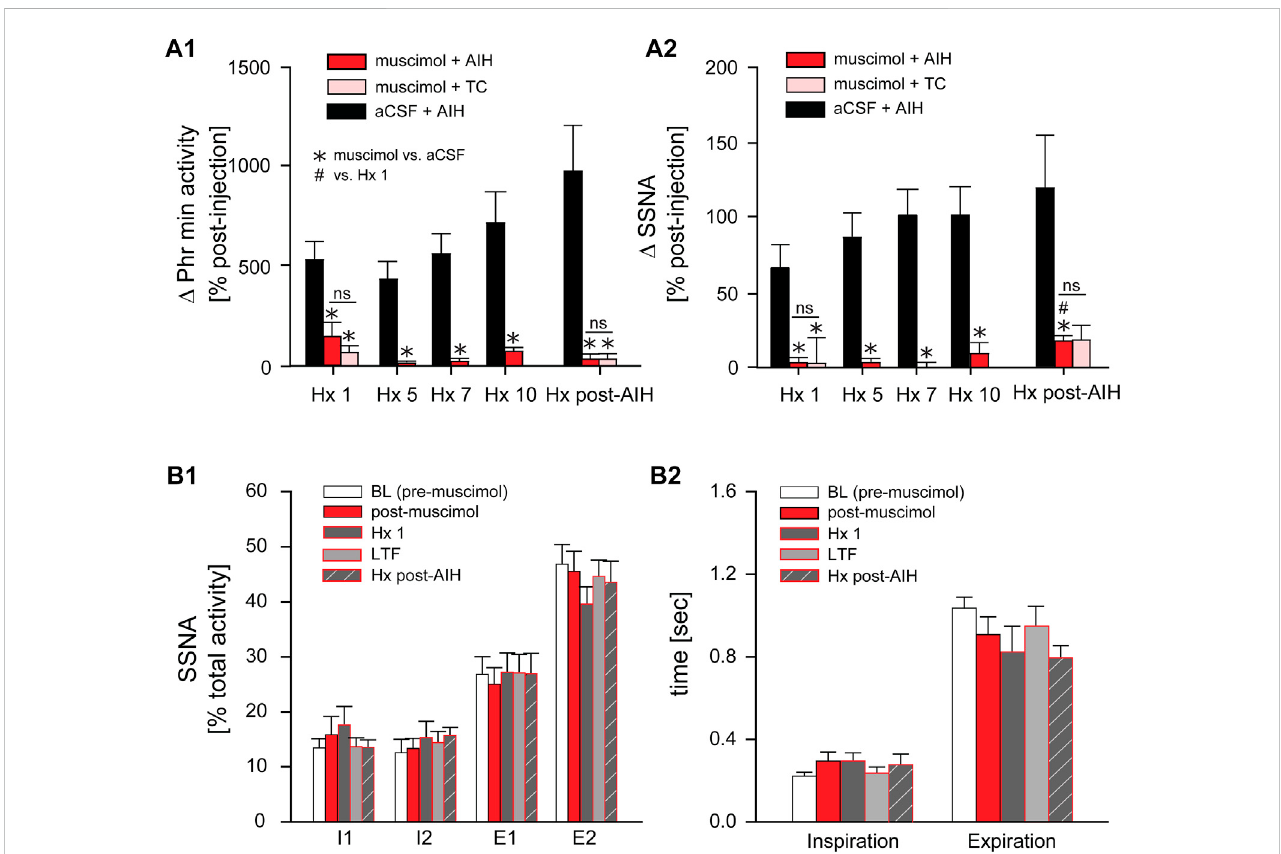
FIGURE 7 Inhibition of nTS activity prior to AIH inhibits PhrNA and SSNA responses to Hx with no changes in sympathorespiratory coupling. (A) : Change in PhrNA (A1) and SSNA (A2) during Hx 1, 5, 7, 10 and Hx post-AIH. Animals received bilateral nTS muscimol injections prior to either AIH (red bars, n = 8; PhrNA, n = 6, SSNA) or TC (pink bars, n = 5; PhrNA, n = 3, SSNA). Changes due to hypoxia were calculated relative to the appropriate pre-Hx baseline. Data for animals exposed to AIH (black bars) without nTS inhibition prior to AIH are presented for comparison (same data as in Figure 4B). Muscimol injections blunted PhrNA and SSNA responses to Hx. No differences were observed between muscimol + AIH and muscimol + TC at Hx 1 or Hx post-AIH (Phr min activity: Hx 1: p = 0.38, Hx post-AIH: p = 0.99; SSNA: Hx 1: p = 0.89, Hx post-AIH: p = 0.65, t -test). Two-way ANOVA for repeated measures: p ≤ 0.05; * aCSF + AIH vs. muscimol + AIH or muscimol + TC, # relative to Hx 1. (B) : Phrenic triggered averages of normalized SSNA (% total activity within a given cycle, (B1 ) and mean time of inspiration and expiration (B2) at baseline (BL, prior to muscimol injection; white bars), post-muscimol injection (red bars), during Hx 1 (grey bars), 1 h after AIH (LTF, light grey bars) and Hx post-AIH (grey striped bars). Most SSNA during baseline occurred during expiration (I1 = I2 < E1 < E2; p ≤ 0.05, One-way